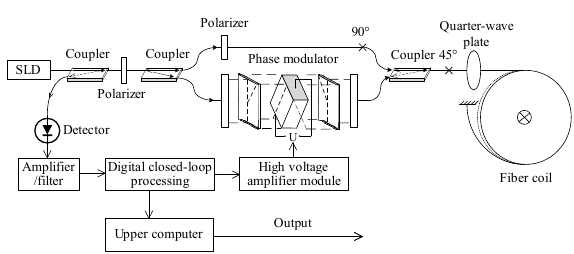
Fig. 1. Structure diagram of FOCT based on spatial phase modulation